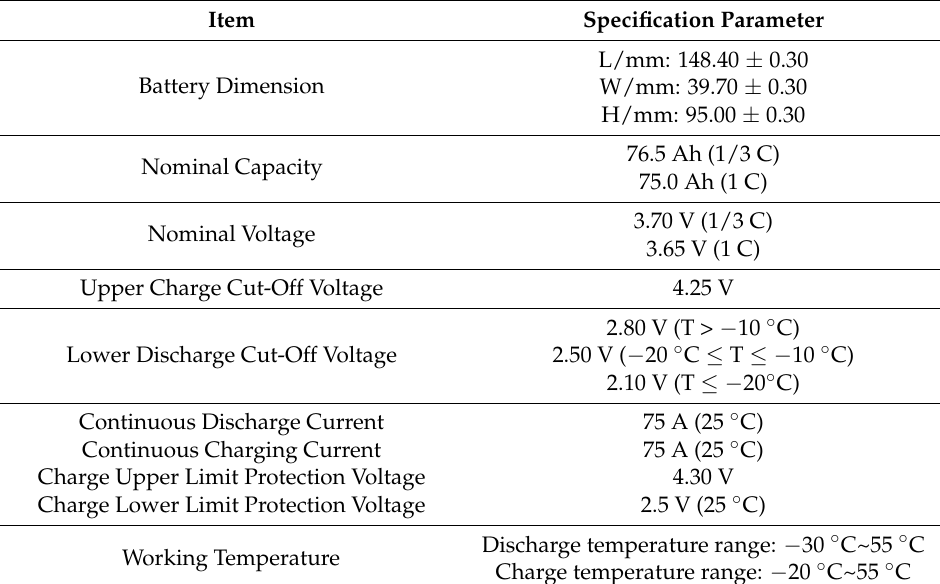
Table 1. The prismatic lithium‐ion battery cell specifications.